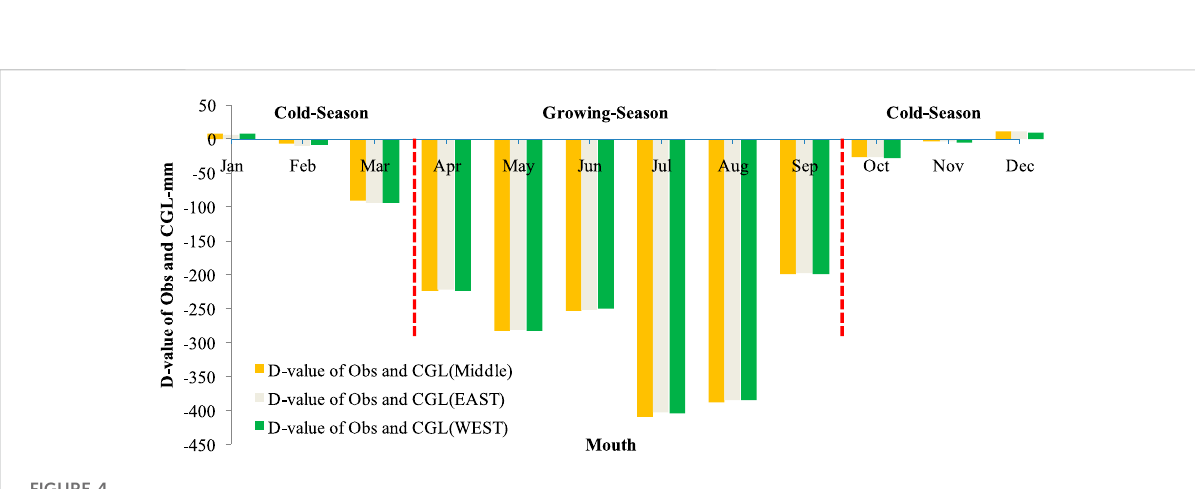
FIGURE 4 Difference between observations and results calculated from CGL (middle, east,